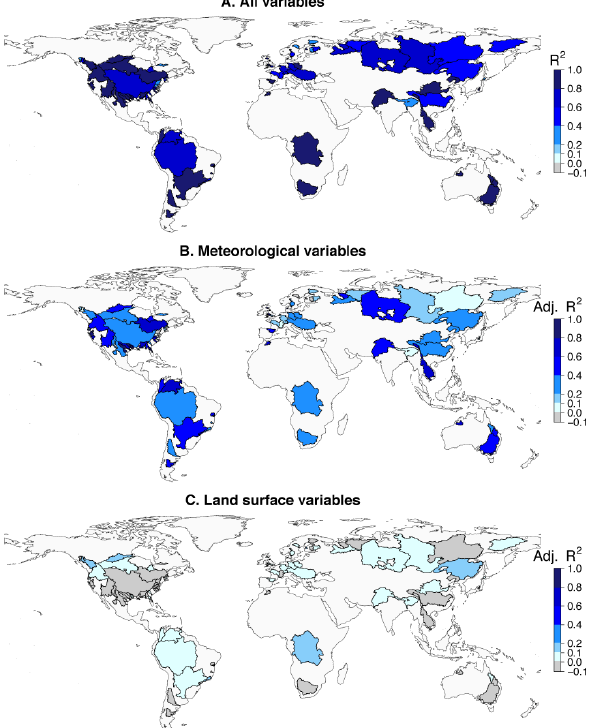
Fig. 3. The proportion of interannual variability in water balance ET explained by all predictor variables in each basin (A) ; and the unique effect of meteorological (B) and land surface (C) variables in controlling ET variability, determined by variance partitioning. All values shown are based on CRU